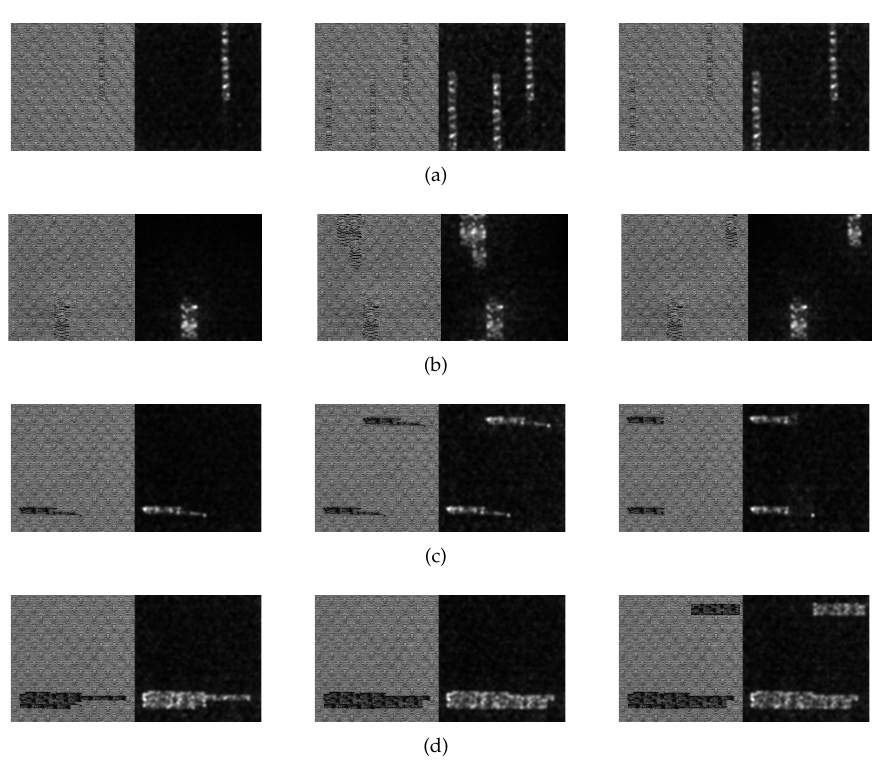
Figure 12. Saliency map of dot-patterned fabric defect detection. ( a ) broken end type; ( b ) hole type; ( c ) thin bar type; ( d ) thick bar